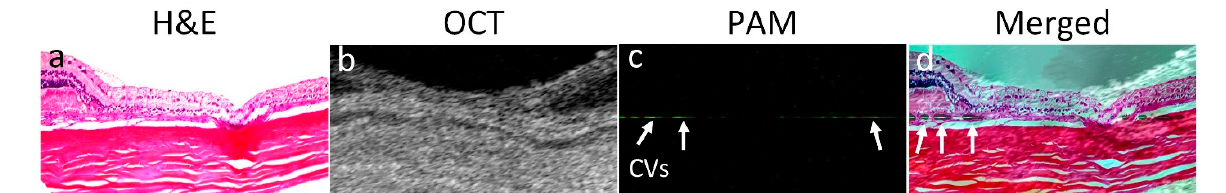
Figure 7. Co-registration of H&E, OCT, and PAM: ( a ) H&E image. ( b ) Cross-sectional OCT image. ( c ) B-scan PAM image. ( d ) Overlay image. White arrows indicate the location of choroidal vessels (CVs).